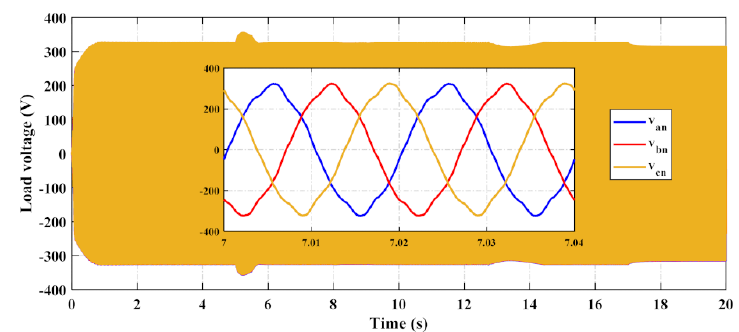
Figure 20. Load instantaneous voltage using BSS only.